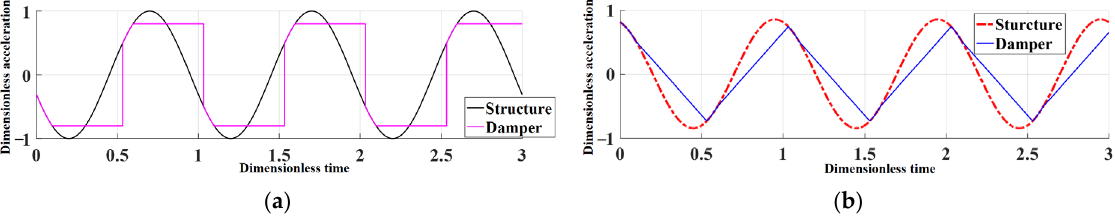
Figure 7. Motion at θ = 12° in stick–slip state ( k = 0.8): ( a ) Acceleration; ( b ) Velocity. Full-Slip State When the value of parameter k in Equation (7) is small enough that there is no stick phase in the whole vibration cycle, it is called full ‐ slip state. The motion of the slip phase of the ring still satisfies Equation (9), and it can be considered that the starting time and the end time of the stick phase are the same, i.e.,